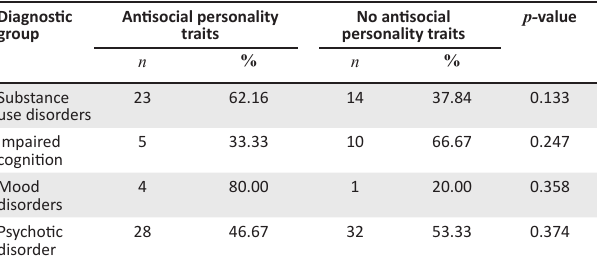
TABLE 4: Prevalence of groups of diagnoses among forensic State patients with and without antisocial personality disorders. Diagnostic group